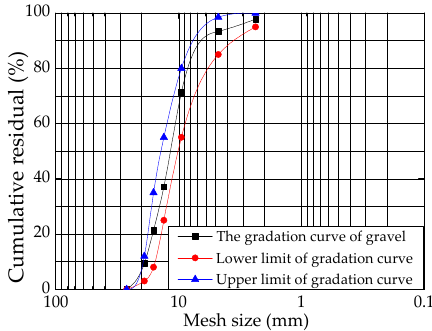
Figure 1. The gradation curve of gravel.